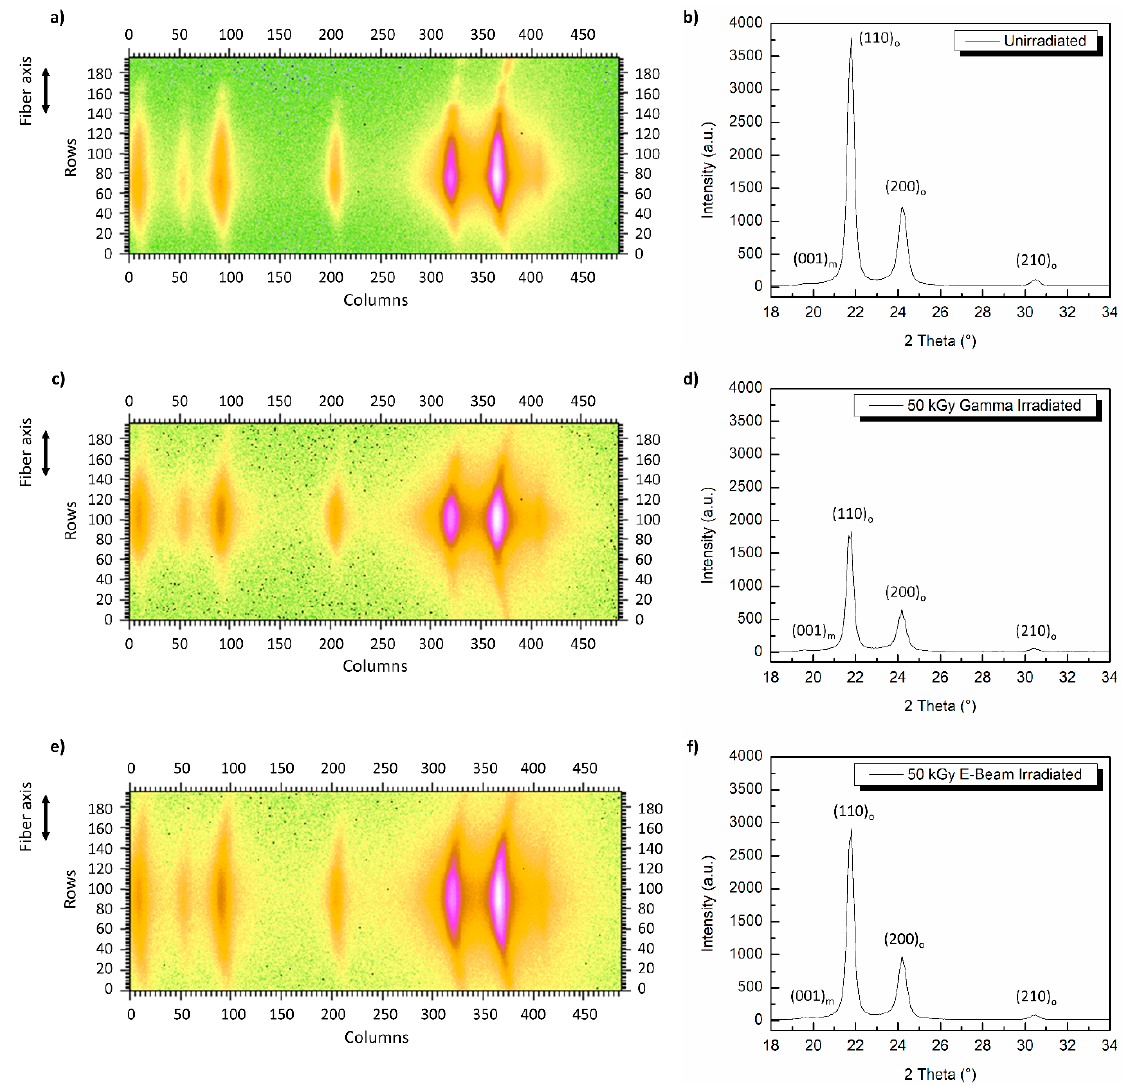
Figure 7. Two-dimensional wide angle X-ray scattering (WAXS) patterns and their corresponding diffractograms for UHMMPE fibers; ( a ) and ( b ) untreated, ( c ) and ( d ) 50 kGy gamma irradiated, ( e ) di ff ractograms for UHMMPE fibers; ( a , b ) untreated, ( c , d ) 50 kGy gamma irradiated, ( e , f ) 50 kGy and ( f ) 50 kGy electron beam irradiated. electron beam